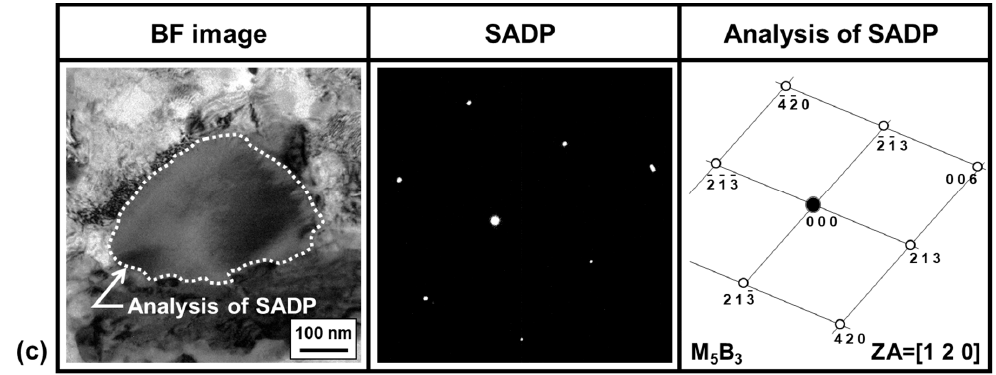
Figure 9. Bright field (BF) images and corresponding selected area diffraction pattern (SADP)-designated areas after laser-assisted fusing treatment of 1276F coating at 1473 K; ( a ) M 7 C 3 , ( b ) M 23 C 6 and ( c ) M 5 B 3